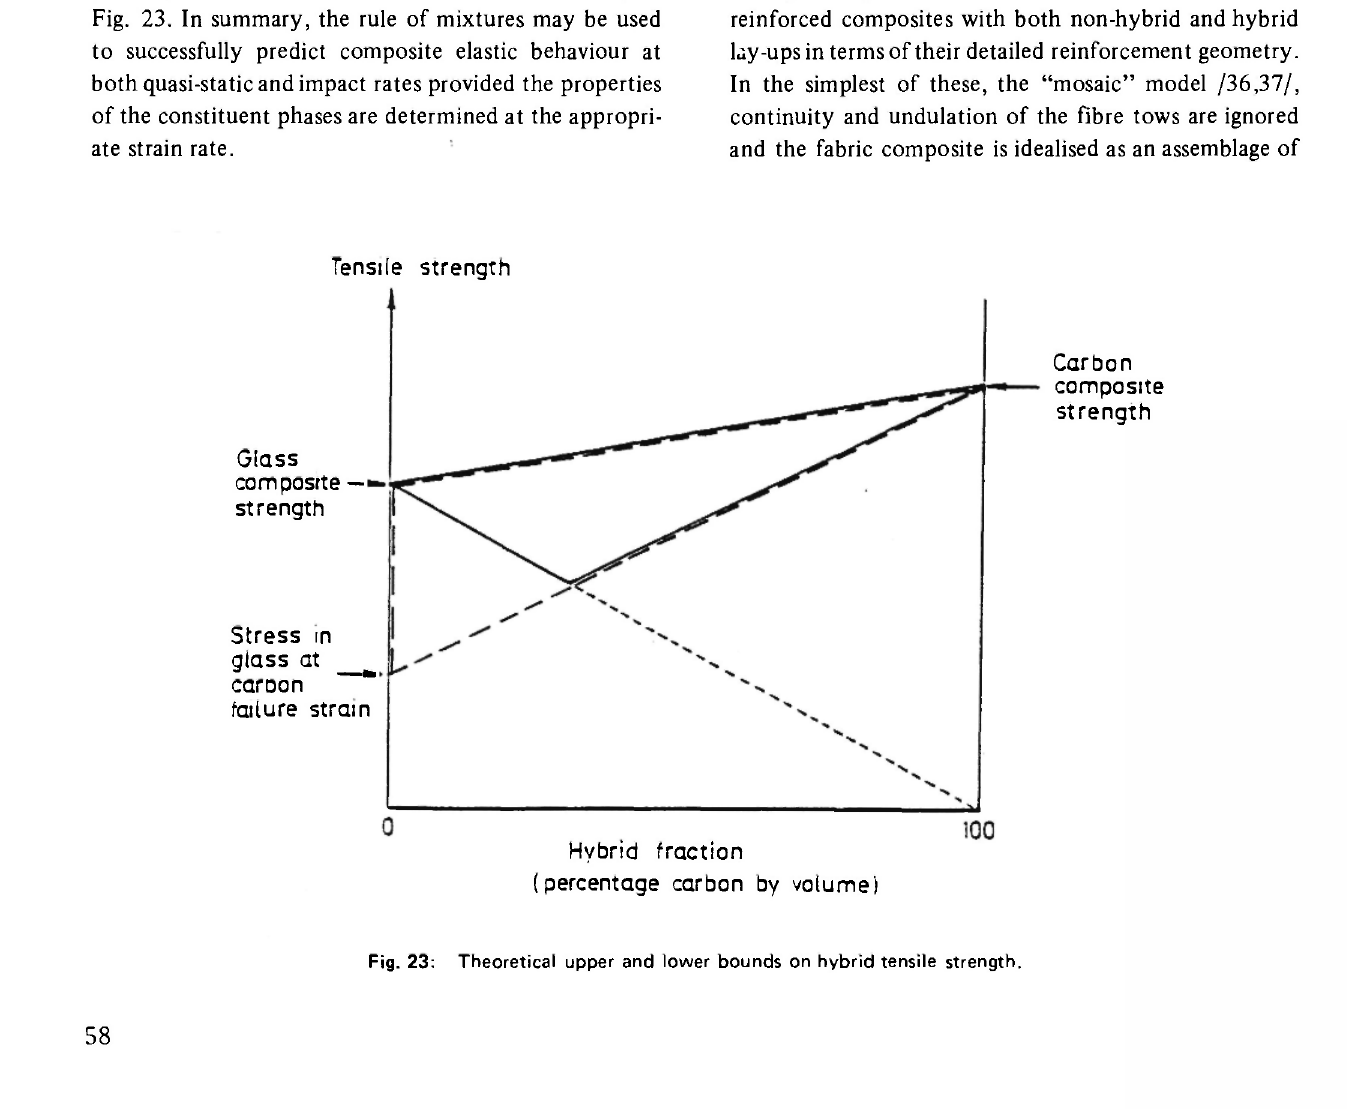
Fig. 23: Theoretical upper and lower bounds on hybrid tensile